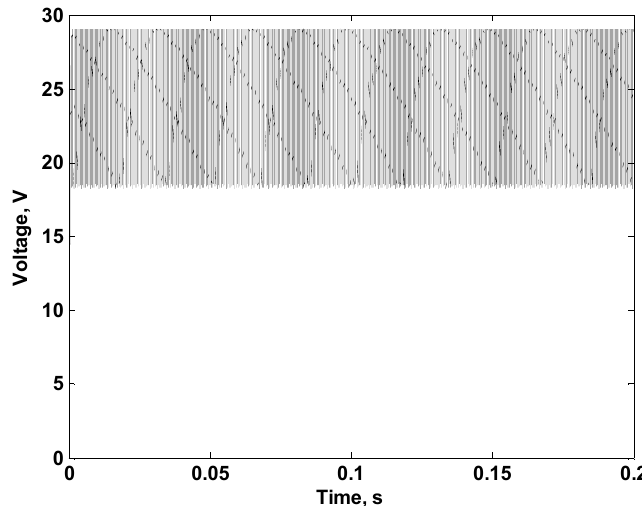
Figure 28. Voltage across the terminals of PV source 1.